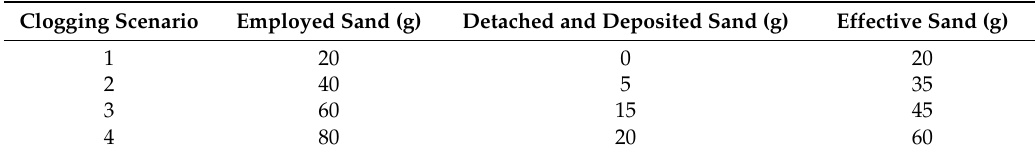
Table 2. Progressive clogging rates with fine sand.